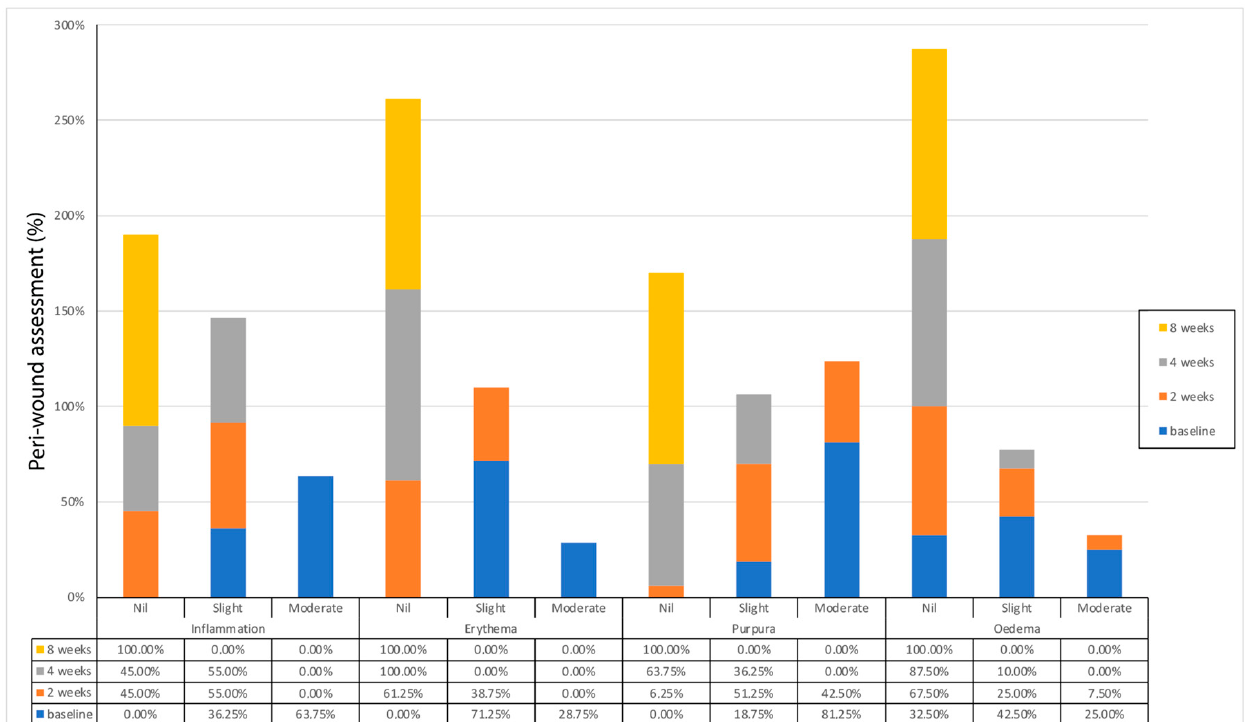
Figure 4. Evaluation of peri-wound inflammation, erythema, purpura, oedema. After 2 weeks, 45% of the treated ulcers showed an improvement in the four parameters analyzed, and at 4 weeks, 74% of the treated ulcers showed further improvement in the four parameters compared to baseline.